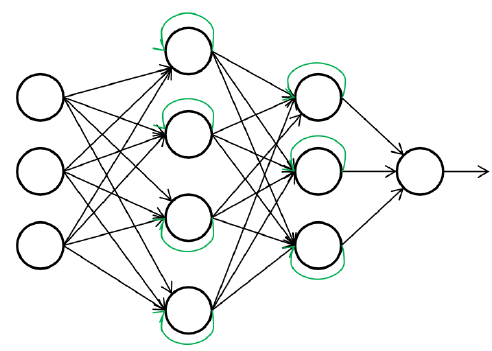
Fig. 2 An example of